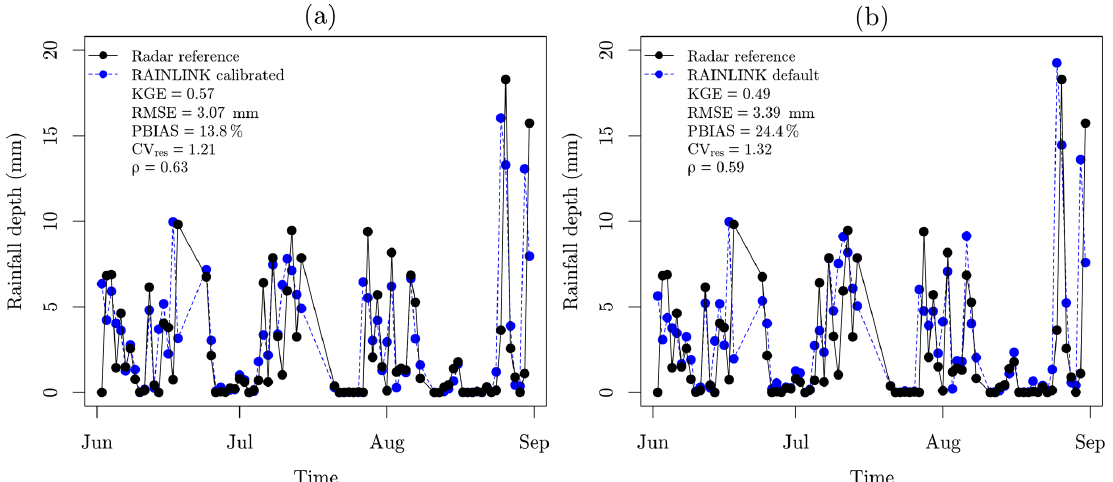
Figure 7. Comparison of the daily mean rainfall depth time series for all of the Netherlands during the summer months of June, July, and August 2012: (a) rainfall time series retrieved by RAINLINK with calibrated parameters; (b) rainfall time series retrieved by RAINLINK with default